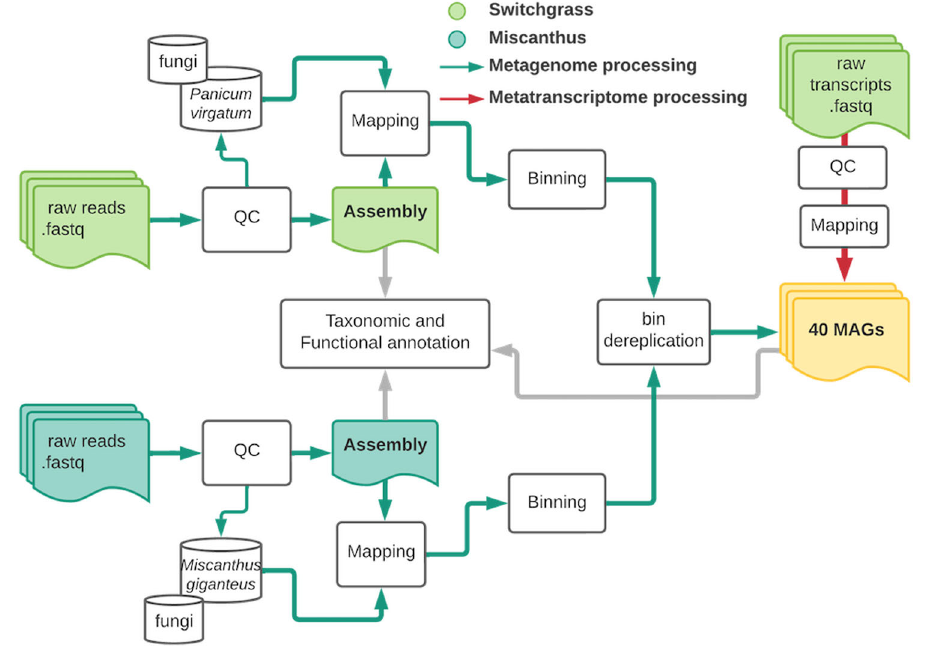
Fig. 2 | Overview of bioinformatic processing of the metagenome (solid green arrows) and metatranscriptome (solid red arrows) datasets. Switchgrass reads are shown in light green, and miscanthus is dark green. The solid grey arrow